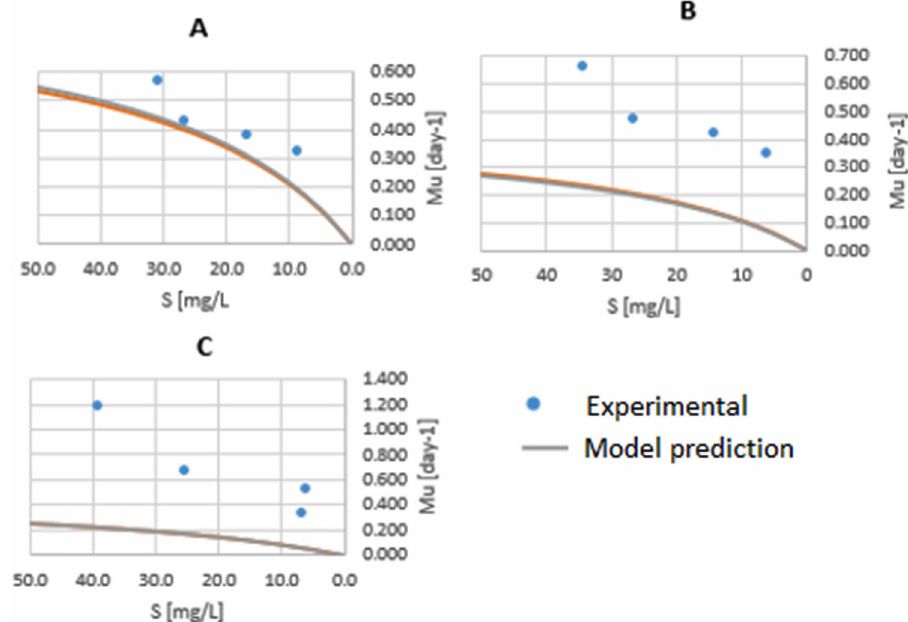
Fig. 6. A comparison between experimental and model prediction of speci fi c growth rate ( m ) at different temperatures: (A) 25 ° C, (B) 35 ° C and (C) 40 °